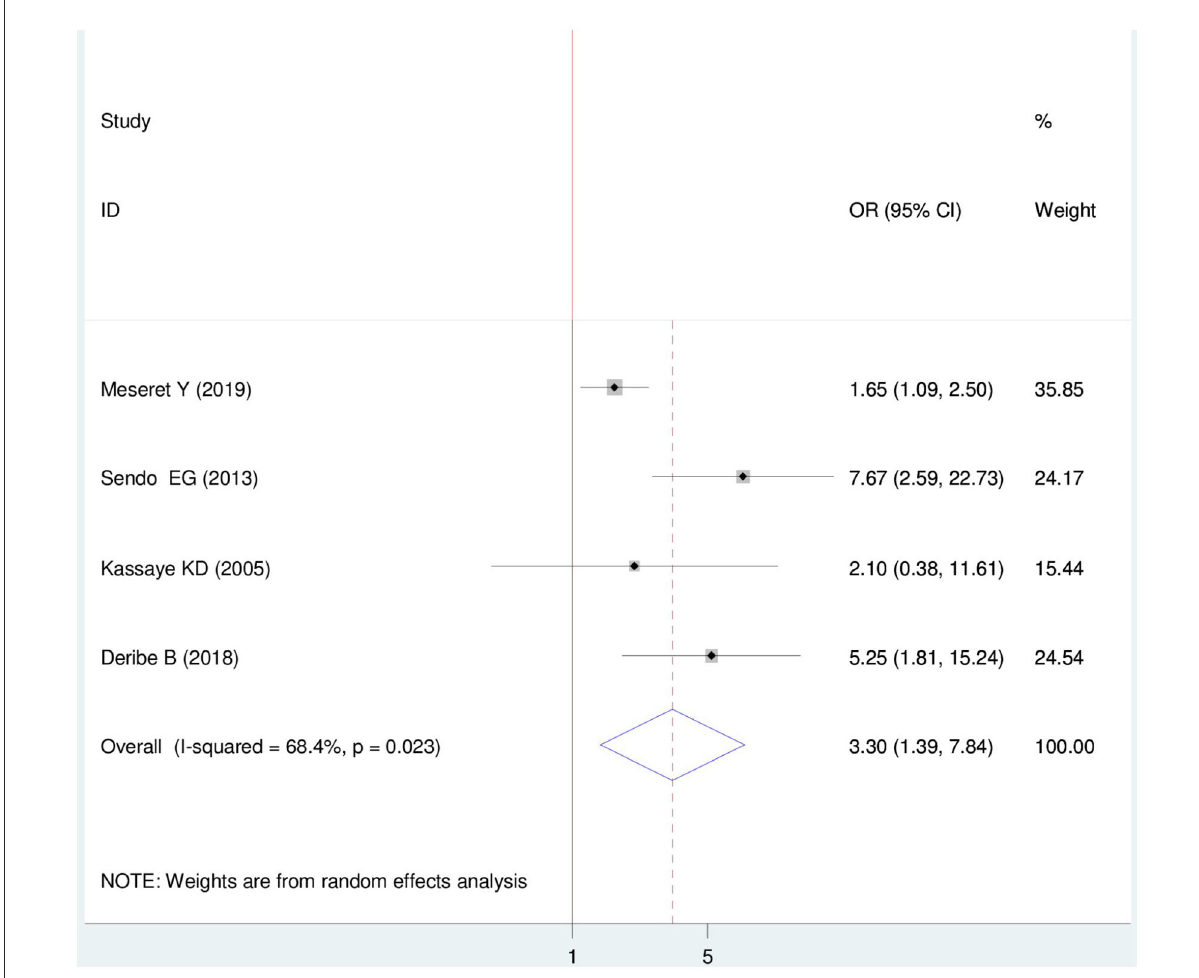
FIGURE8 Forest plot of association between HIV sero-status disclosure and relationship before test among women in East Africa,